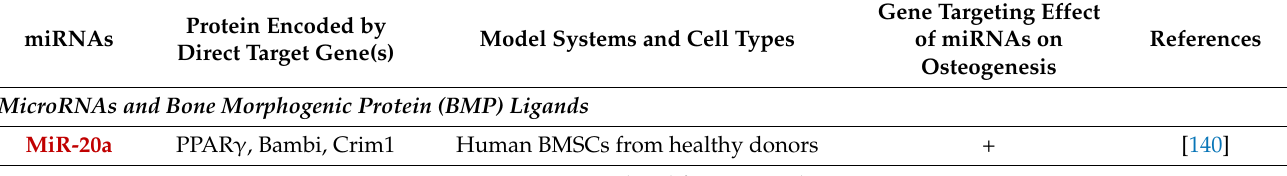
Table 2. List of microRNAs implicated in the BMP signalling pathway in various model systems and cell